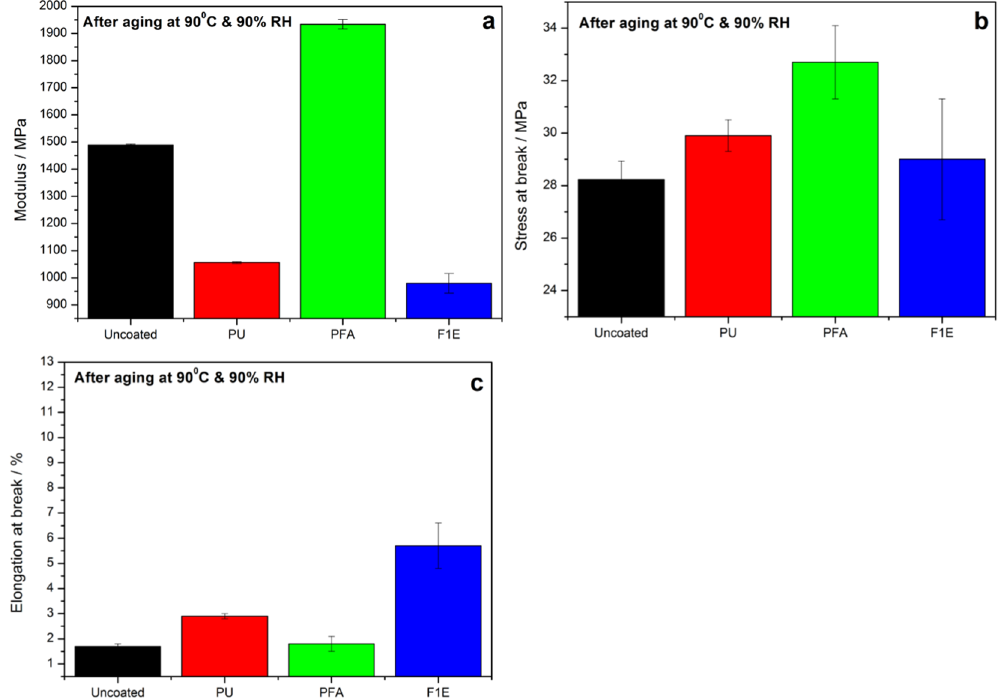
Figure 5. ( a ) Tensile modulus ( b ) Tensile stress at break and ( c ) elongation at break of uncoated and coated phenolic/flax fibre laminates after